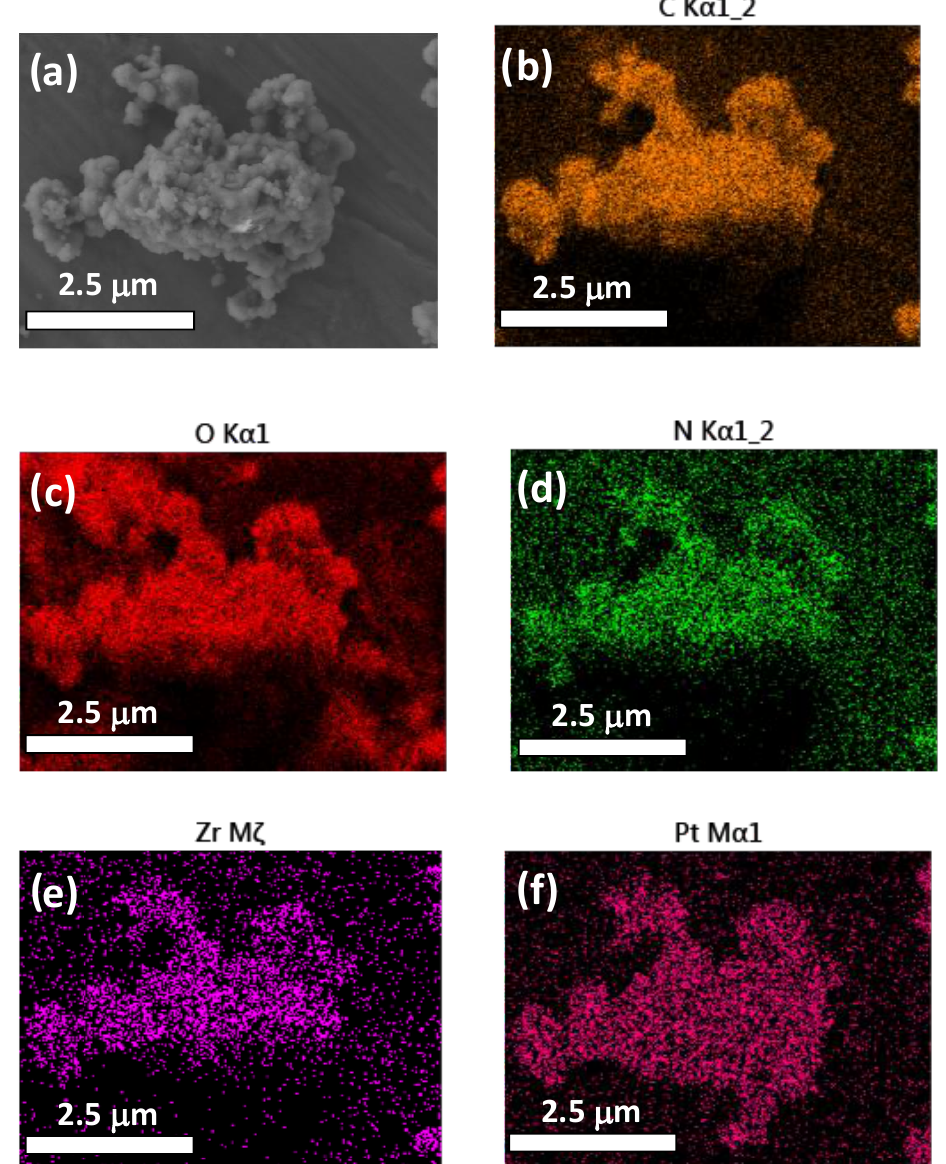
Figure 8. HR-SEM image of Pt@UiO-66(Zr)-NH 2 ( a ) and EDX mapping: carbon ( b ), oxygen ( c ), nitrogen ( d ), zirconium ( e ), platinum ( f ).